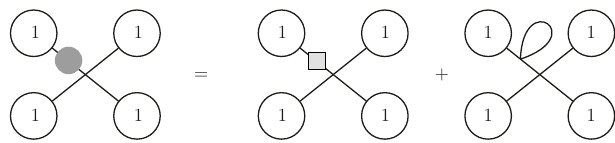
Figure 3 . Topologies entering in c 4 from thee NLO contribution to the (cid:17) and (cid:17) 0